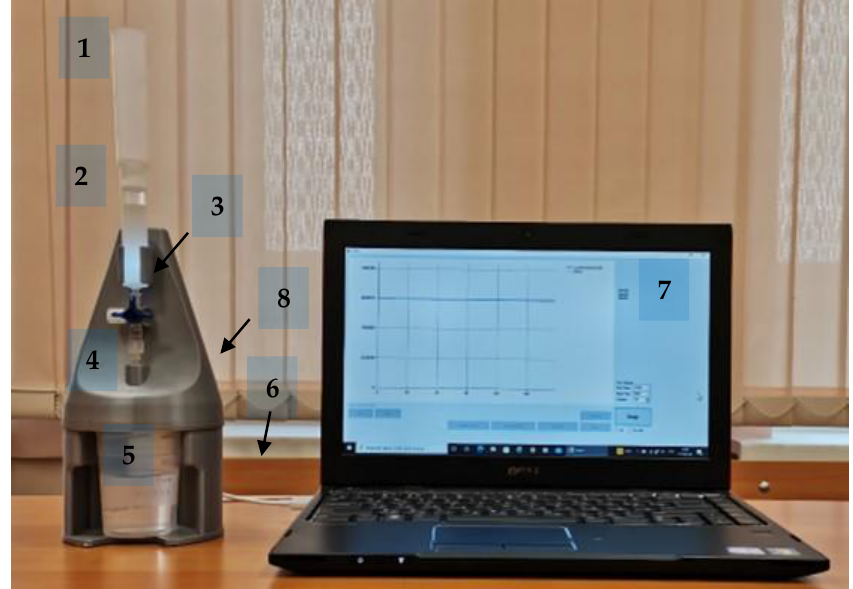
Figure 2. Optical chemical sensor for protein determination in effluent peritoneal dialysate ( 1 is the LabMate buffer reservoir; 2 is the PD-10 column; 3 is the three-way valve; 4 is the photometric unit; 5 is the drain vessel; 6 is the USB interface cable; 7 is the laptop; 8 is the liquid flow rate adjustment screws).